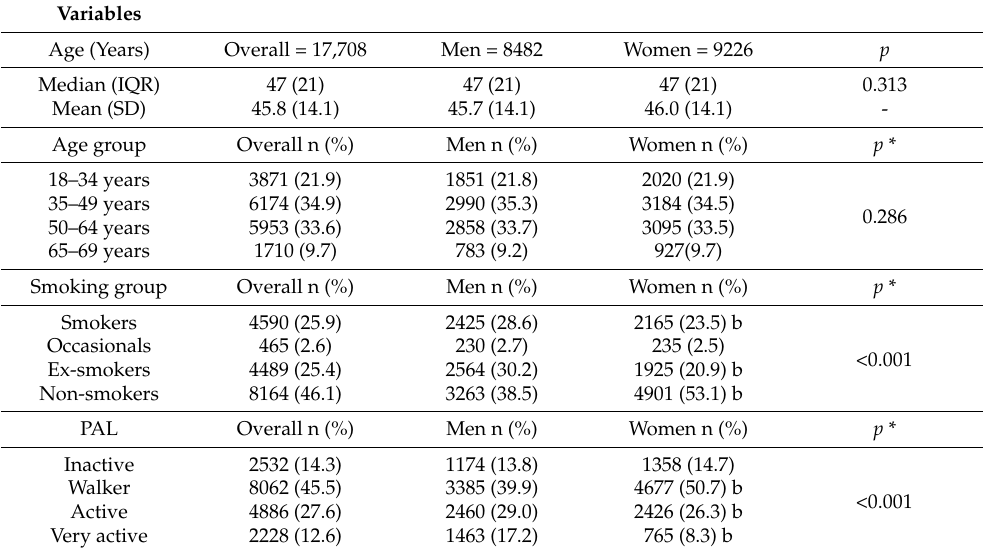
Table 1. Socio-demographic characteristics, smoking status, and physical activity level of the Spanish population aged 18–69 years in